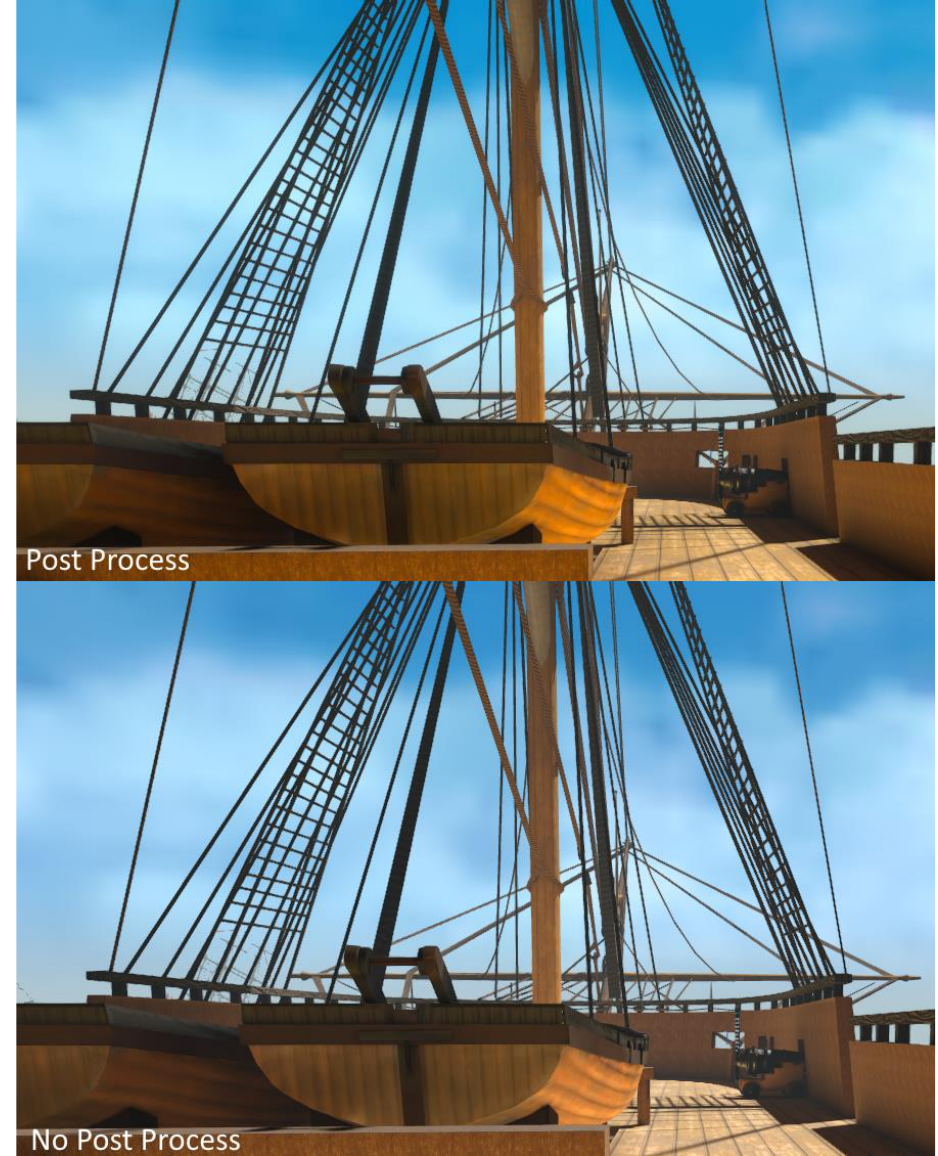
Figure 16 . Top — scene with post-processing; bottom — scene without post-processing. Figure 16. Top—scene with post-processing; bottom—scene without